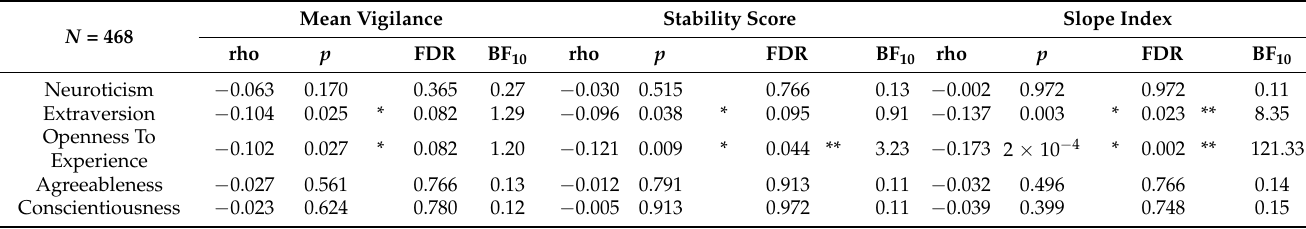
FDR: False Discovery Rate according to Benjamini and Hochberg; BF 10 Bayes factor showing the likelihood ratio between the alternate and null hypothesis (1/3 beta prior width). * p < 0.05 (two-tailed nominal significance). ** FDR < 0.05 ( p -value corrected for all tested associations using FDR